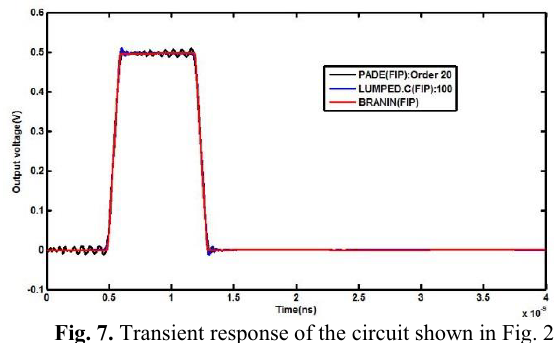
Fig. 3. Circuit topology of the complex pole-zero subsection